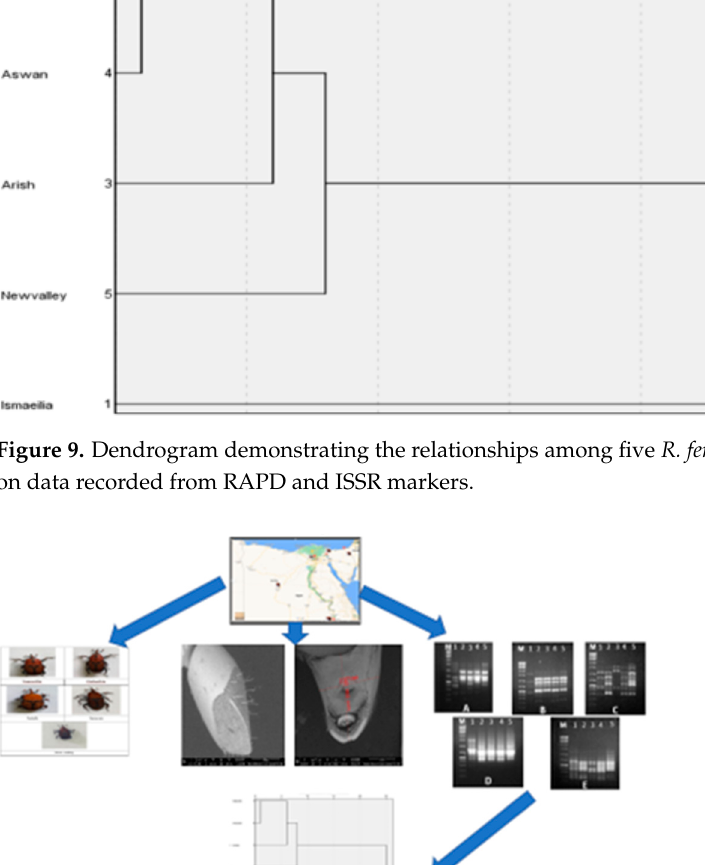
Table 7. Genetic distance values among populations R. ferrugineus from five governorates